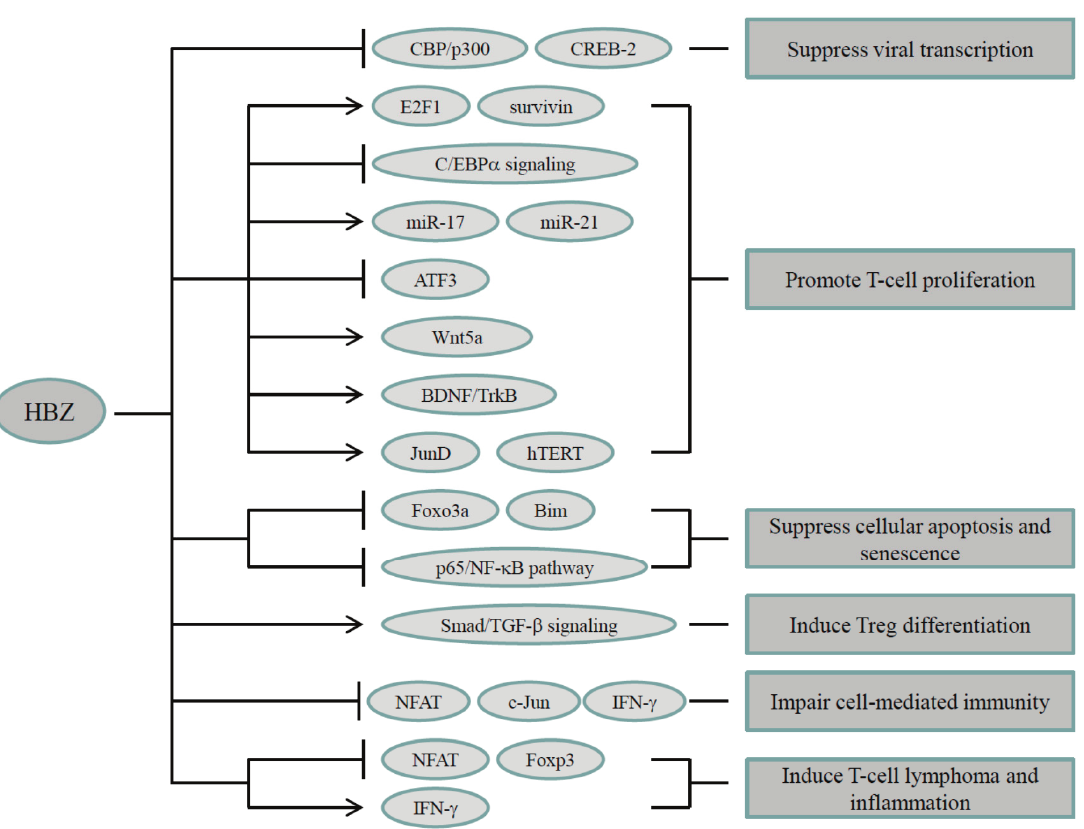
Figure 2. Oncogenic function of HBZ. HBZ fulfills its oncogenic functions mainly through regulating HTLV-1 5' LTR transcription and modulating a variety of cellular signaling pathways that are related to cell growth, apoptosis, immune escape, T-cell differentiation, and HTLV-1 pathogenesis. Detailed descriptions can be found in the text.